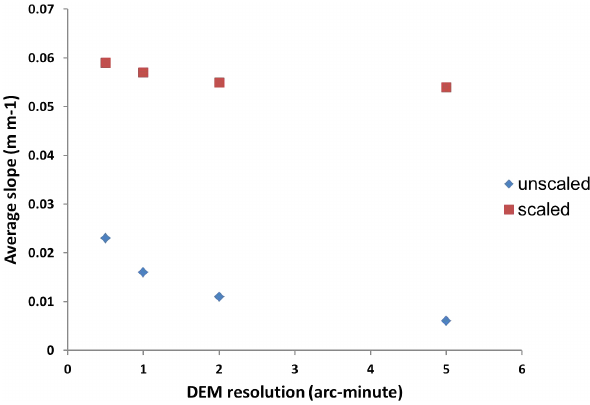
Figure 1. Global average unscaled slope estimated from different coarse resolution digital elevation models (DEMs) as function of their resolution (blue), and global average scaled slope from the same DEMs as function of their resolution